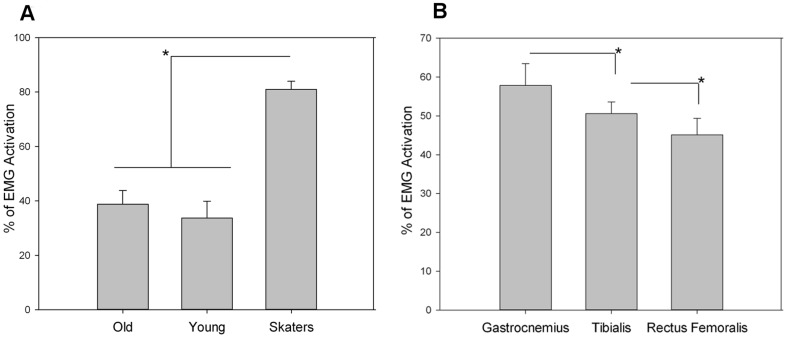
Means and standard deviations of the EMG magnitude expressed in percentage over the baseline: A) across groups and B) across the three lower legs muscles.The * symbol indicates the level of significance <0.05.